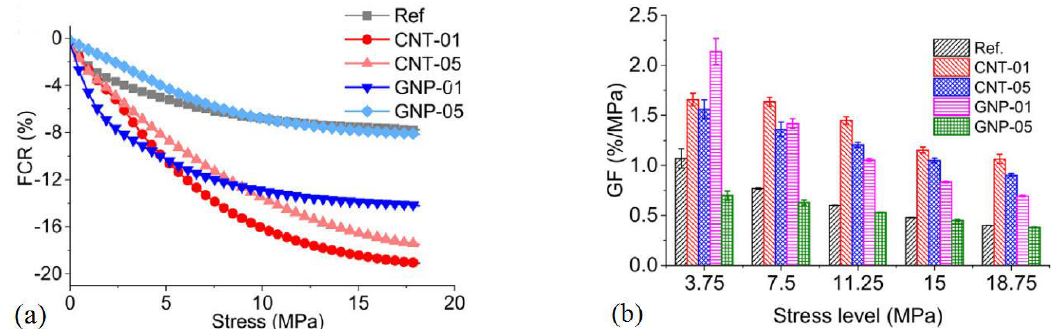
Figure 27. Piezoresistive results of cement composites: ( a ) Fractional change ratio of electrical resistivity of GNP and CNT reinforced samples; ( b ) Gauge factor of GNP and CNT reinforced samples. Reprinted with permission from Ref. [122].